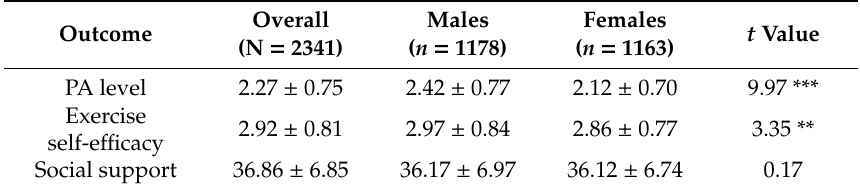
Table 1. Descriptive statistics and sex di ff erences in PA level, exercise self-e ffi cacy and social support. (M ± SD).